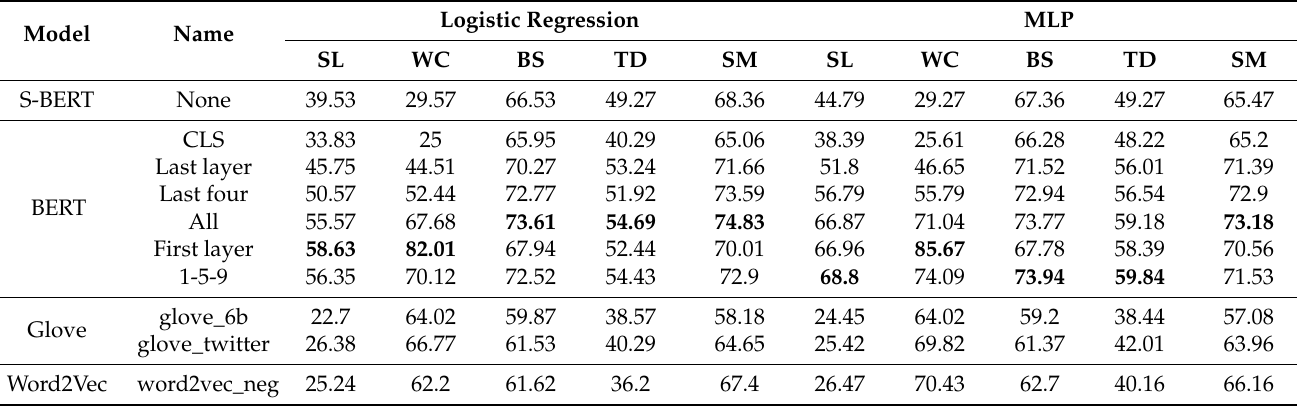
Table 10. Classification accuracies for different sentence vectors (SL—SentLen, WC—WC, BS—BShift, TD—TreeDepth,